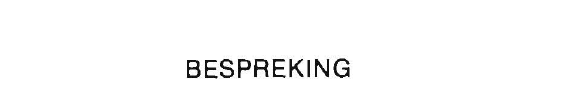
Fig. 3: Gewas met fokus van gevakuoleerde selle (V) asook 'n groep inflammatoriese limfosiete (pyl). HE X 200